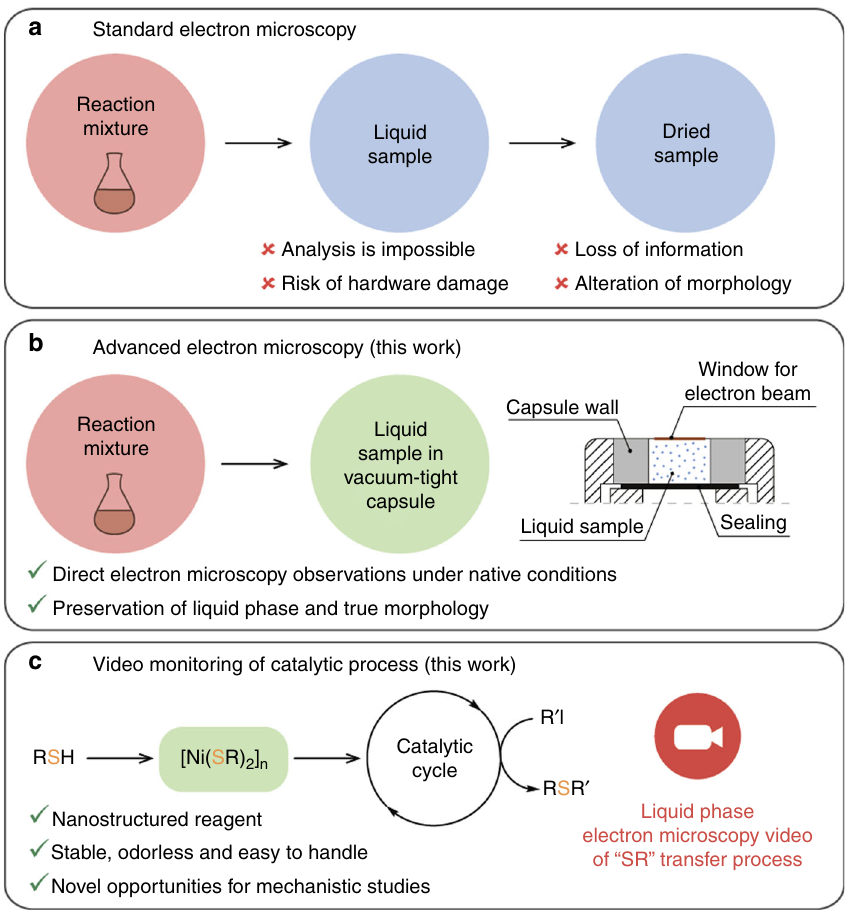
Fig. 1 Electron microscopy studies of the catalytic reactions. Standard solid-phase electron microscopy ( a ), advanced liquid-phase electron microscopy approach ( b ); and application of liquid-phase electron microscopy for observation of nanostructured reagent behavior in catalytic cross-coupling reaction ( c